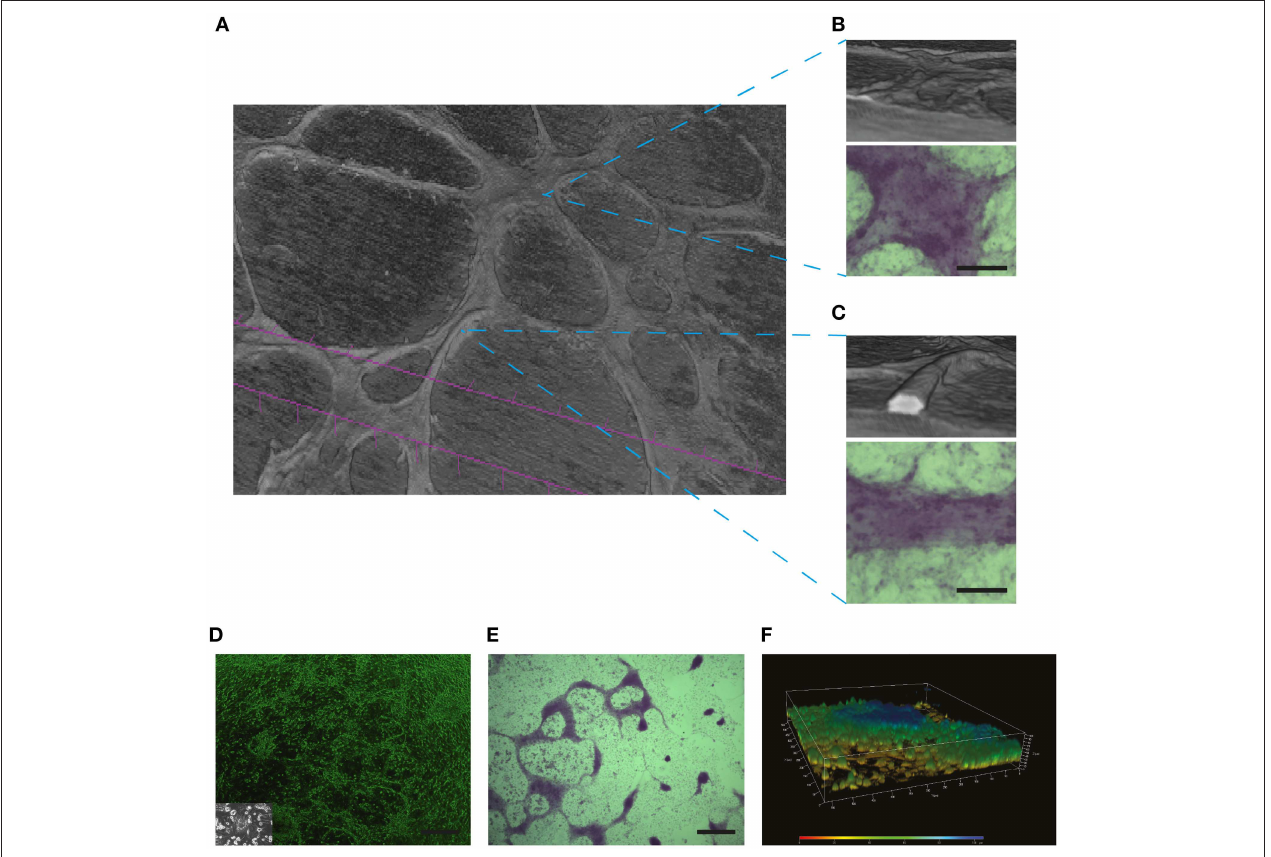
FIGURE 6 | PAS positive structures may not necessarily represent the presence of VM: In (A) Micro-CT 3D reconstruction of the SKOV3 ovarian cancer cell line after 4 days culture in Matrigel demonstrating the presence of elevated structures over a cell monlayer. (B) A flatter yet elevated section of the culture did not demonstrate a lumen when reconstructed by Micro-CT, yet this structure stained positive for PAS (lower panel). Size bar represents 100 µ m. (C) Reconstruction by Micro-CT demonstrates the presence of a lumen containing structure, as demonstrated by the interior white space. The PAS positive stain is shown in the lower panel. Size bar represents 100 µ m. In (D–F) a characterization is shown of structures formed by primary cultures of glioblastoma cells. These samples where obtained with Ethical Committee approval and written patient consent from the Clinical Hospital of the University of Chile, Santiago, Chile. Cell culture was as described previously in Racordon et al. ( 6). (D) Light microscopy imagery of primary cultured cells grown on matrigel, with an image of the cells grown in plastic in the inlay. Size bar represents 500 µ m. (E) Primary cultured glioblastoma cells presented elevated structures over the cell monolayer that stained for PAS. Size bar represents 500 µ m. (F) Confocal 3D reconstruction using ZEN 2012 demonstrates that the PAS positive structures observed in (E) are elevated over the cell monolayer but do not possess a